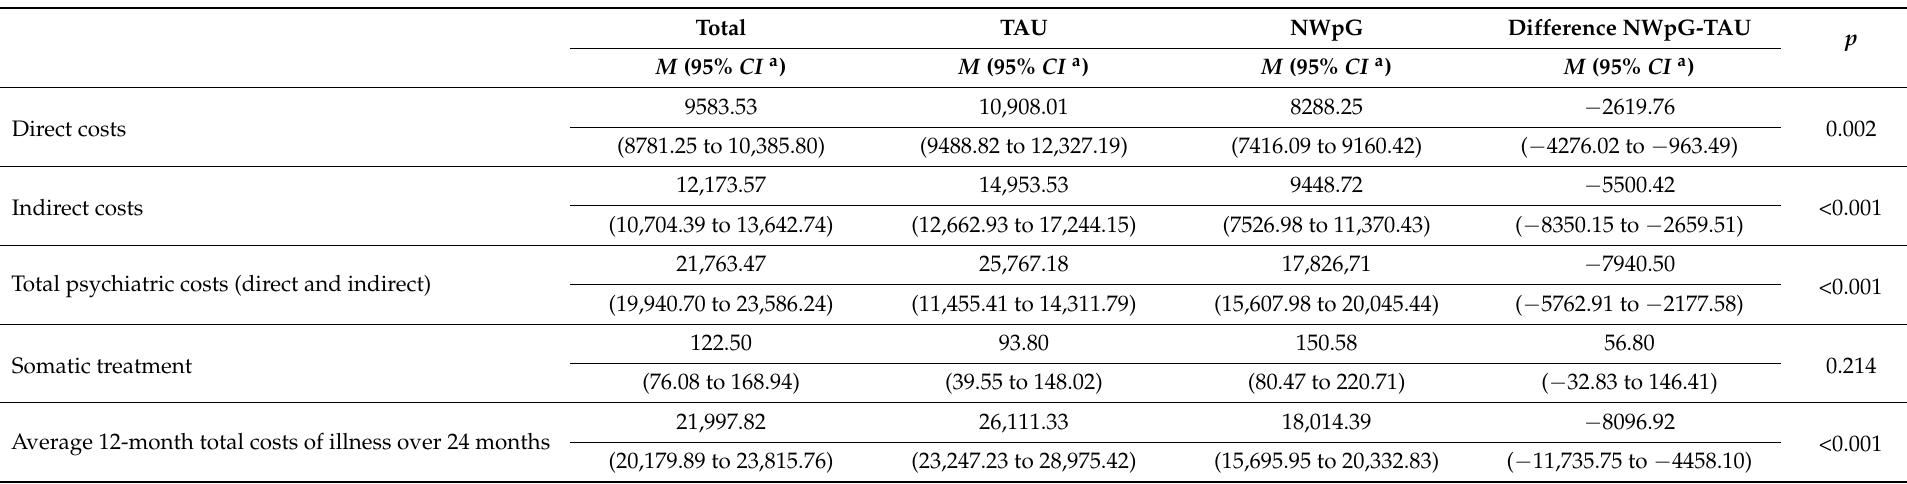
Table 2. Average 12-month cost of illness over 24